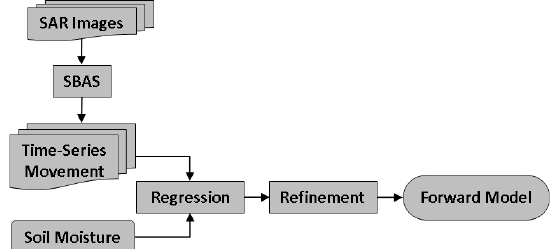
Figure 1. Forward model by regressing soil moisture on time- series movement derived by SBAS.